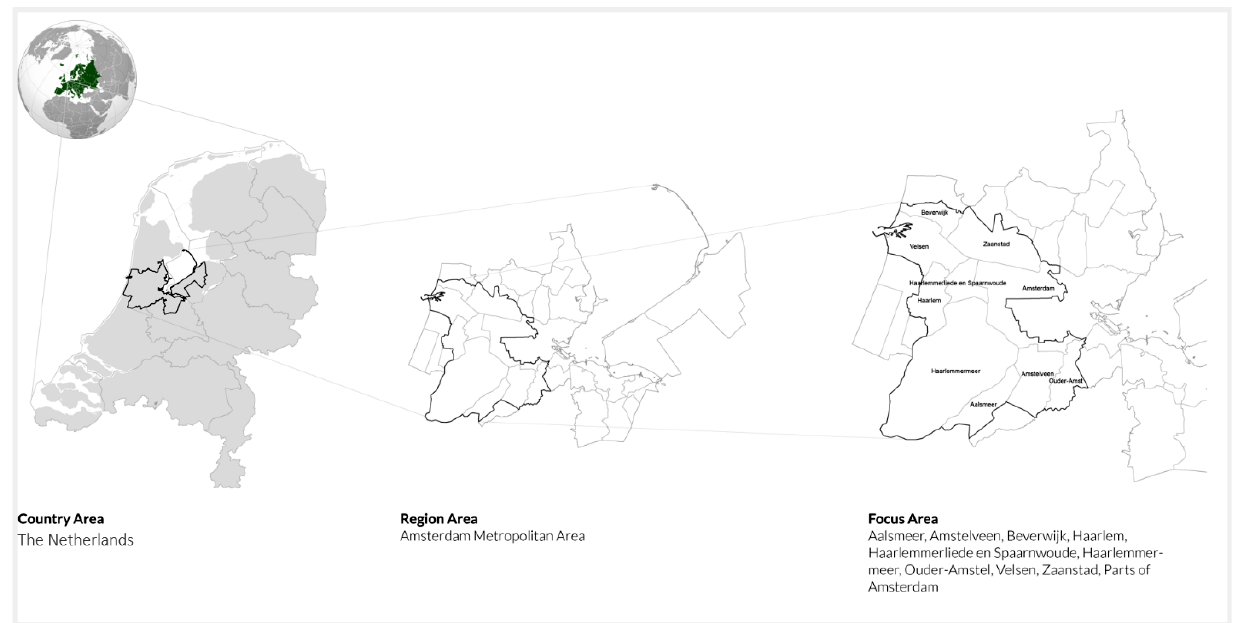
Figure 7. Location of the AMA and its focus